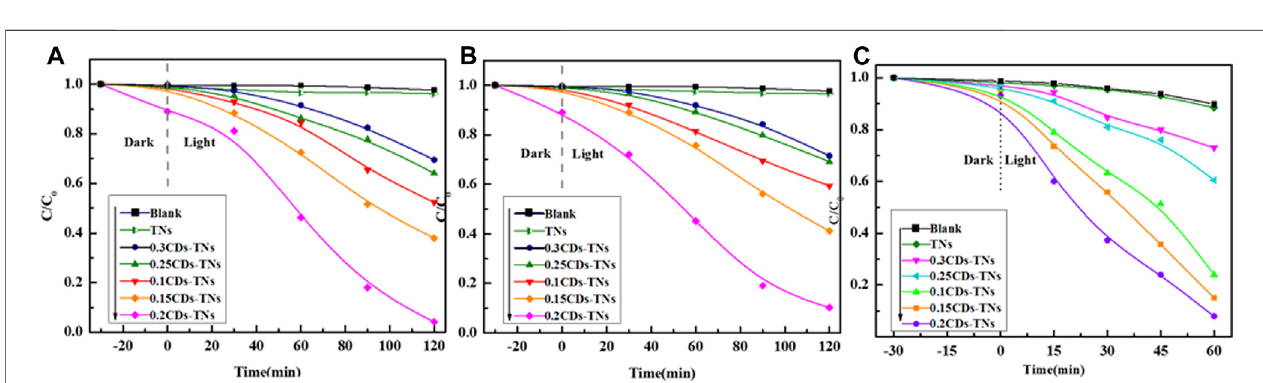
FIGURE 9 | Photodegradation of (A) Congo red, 120 ppm, (B) RhB, 20 ppm, and (C) TC, 80 ppm by CD-TN composites with different contents of CDs under visible light.